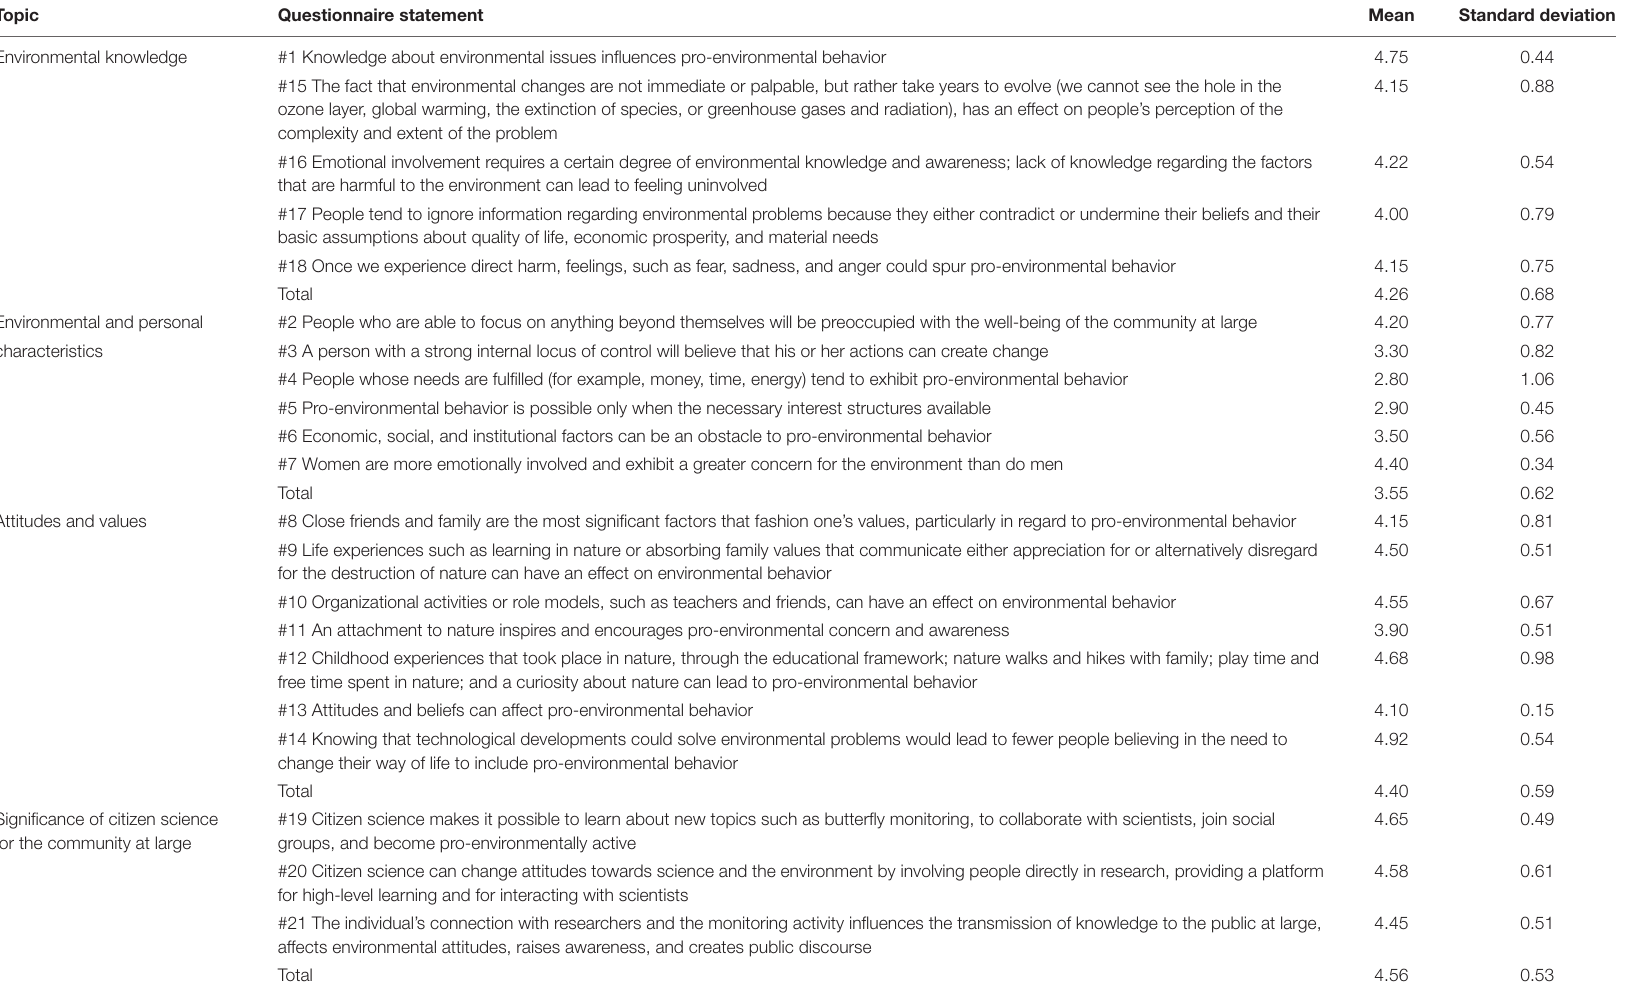
TABLE 2 | Statistical results regarding the factors driving pro-environmental behavior. Topic Questionnaire statement Mean Standard deviation Environmental